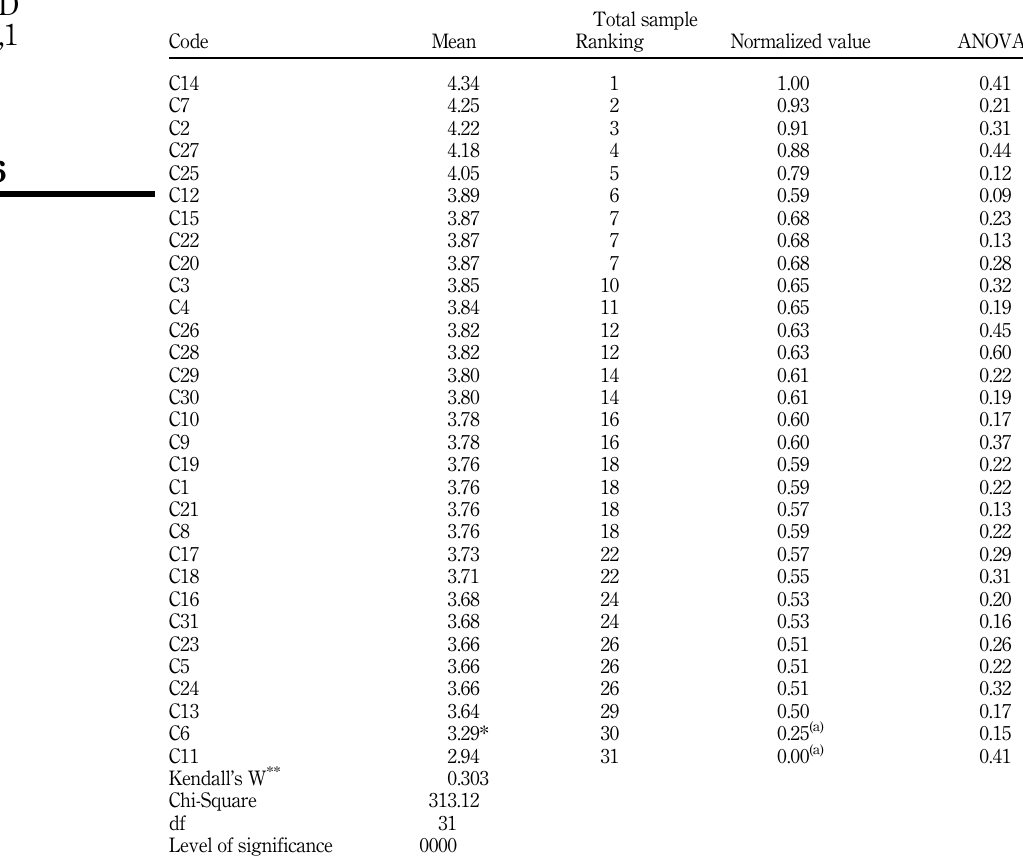
Table 3. The result of mean ranking